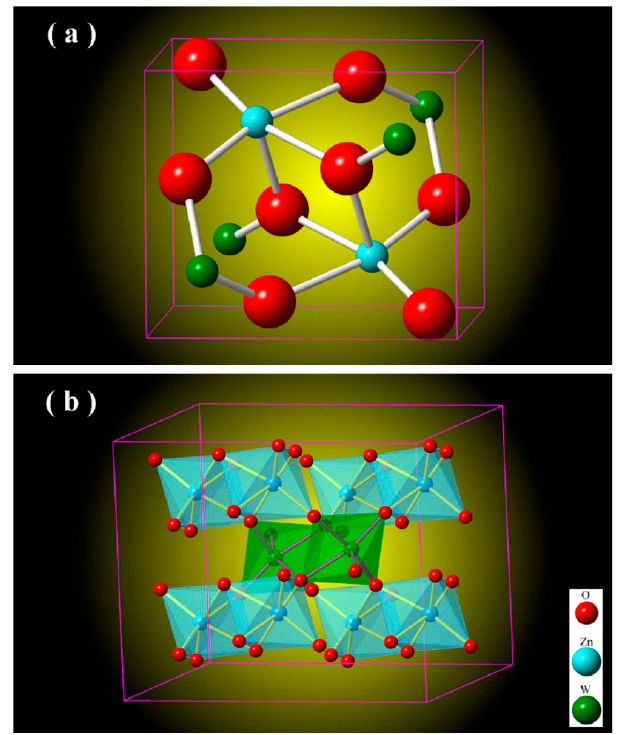
Figure 2. ( a ) Unit cell of monoclinic ZnWO 4 ; ( b ) Metal–oxygen octahedrons in monoclinic ZnWO 4